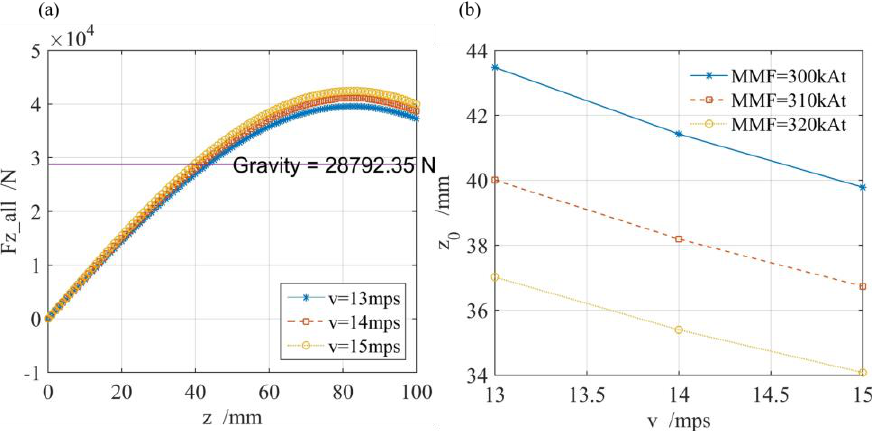
Figure 7. Theory equilibrium point: ( a ) F z_all ( z ) when v ∈ [ 13, 14, 15 ] mps and MMF = 300 kAt; ( b ) theory vertical equilibrium point z 0 at MMF ∈ [ 300,310,320 ] kAt and v ∈ [ 13, 14, 15 ]